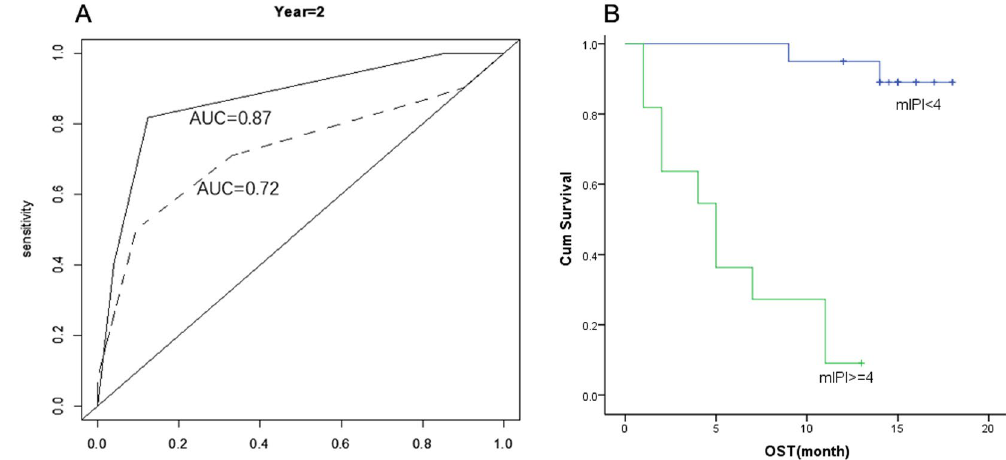
Figure 2. The Survival analysis using a model constructed by CD16 − /CD16 + monocytes and IPI (mIPI score system). ( A ) The survival receiver operating characteristic (ROC) curve of 2-year-survival for CD16 − / CD16 + monocytes ratio and IPI model. AUC was 0.87, which was significantly higher than IPI (dash line) alone. ( B ) The estimated 2-year-survival was 89.1 ± 7.3% and 9.1 ± 8.7% for mIPI < 4 and ≥ 4 respectively.